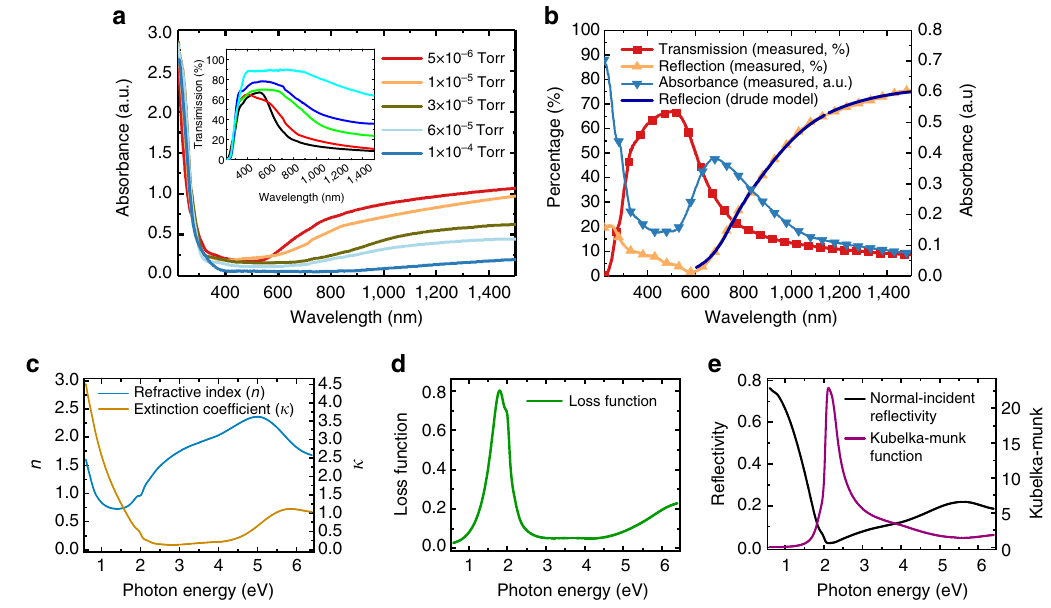
Figure 2 | The optical properties of SrNbO 3 þ d films. ( a ) Ultraviolet–visible–NIR spectra of SrNbO 3 þ d thin films deposited at various oxygen partial pressures, an absorption edge located at the wavelength of 300nm can be observed. ( b ) The transmission, reflection spectra of the film deposited at 5 (cid:3) 10 (cid:2) 6 Torr, with the absorbance spectrum obtained as plot in red. Ellipsometry analysis of ( c ) the refraction index ( n ) and extinction coefficient ( k ). ( d ) Loss function and ( e ) reflectivity of SrNbO 3 as a function of photon